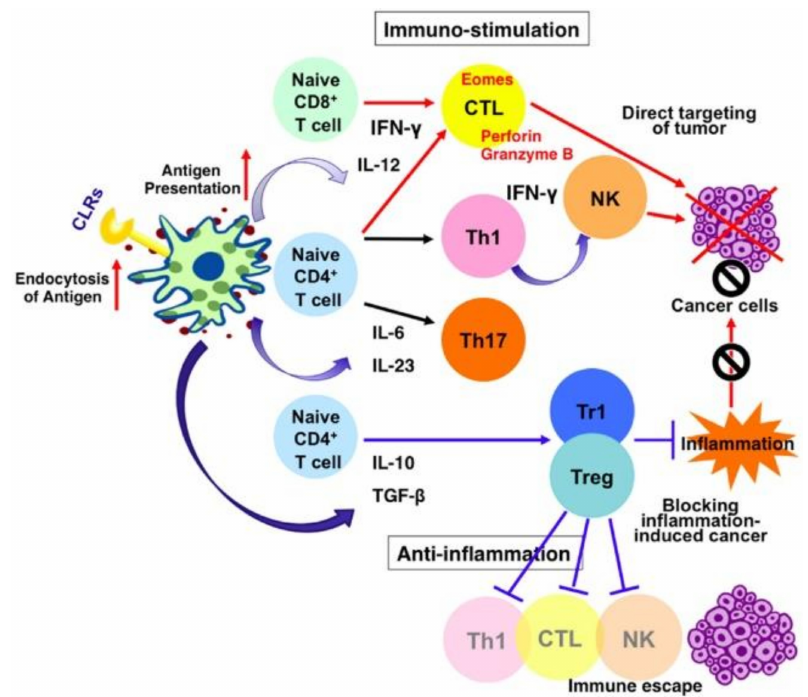
Figure 1. Targeting immune mediators [18]. CLR—C-type lectin receptors; CTL—cytotoxic T lymphocyte; IFN—interferons; IL—interleukins; NK—natural killer; TGF- β —transforming growth factor β ; Th—T helper cell; Treg—regulatory T cell.